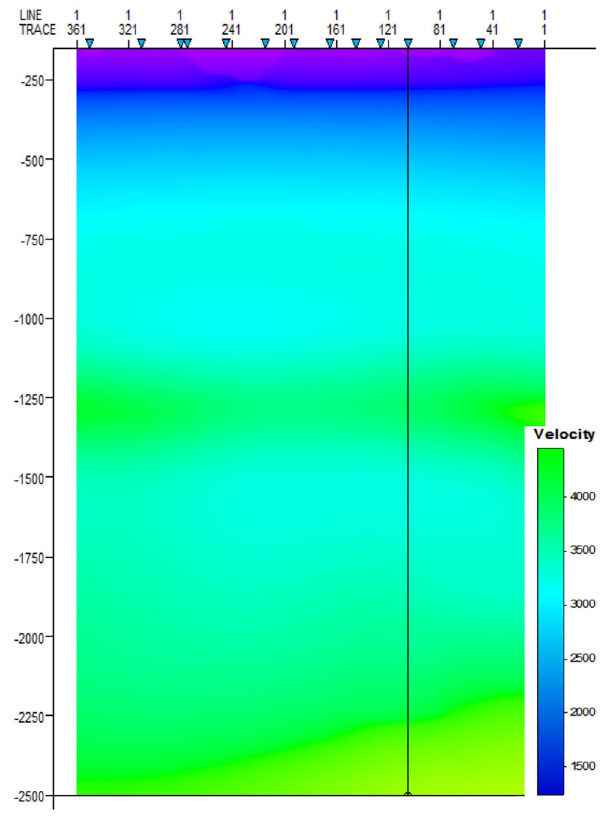
Fig. 9 2D cross-sectional RMS velocity model for all CDPs along inline 10235